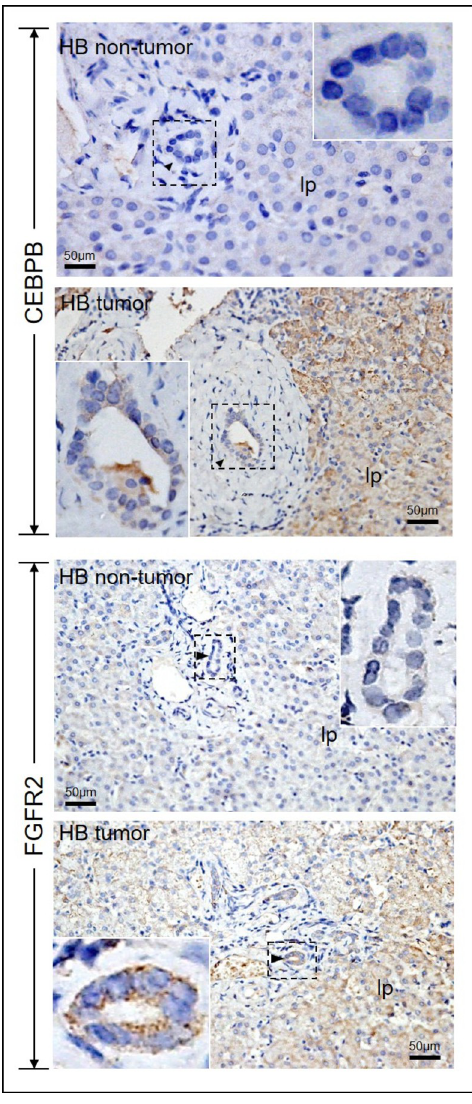
Fig 4. Immuno-histochemistry for FGFR2 and CEBPB in HB livers. CEBPB and FGFR2 immuno-reactivity (brown) was localized to the bile duct (arrowhead) or liver parenchyma (lp). Regions highlighted were enlarged and shown as insets.